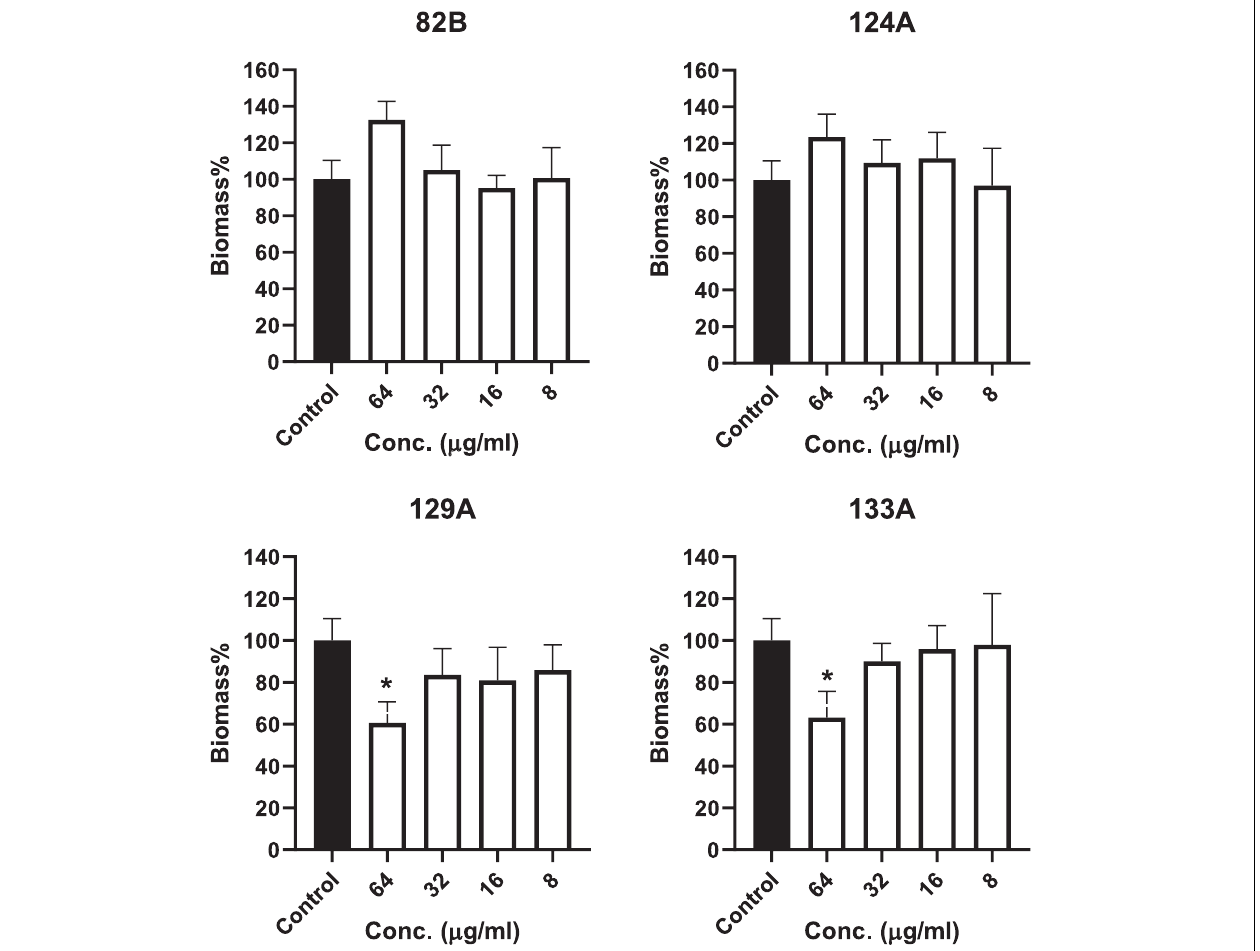
FIGURE 6 | Compound influence on biofilms were assessed. Biofilm biomass was determined by crystal violet staining. (*) refers to significant values with p < 0.05 based on a student t -test comparing the biofilms treated with respective compounds to the control biofilms (incubated with PBS only).